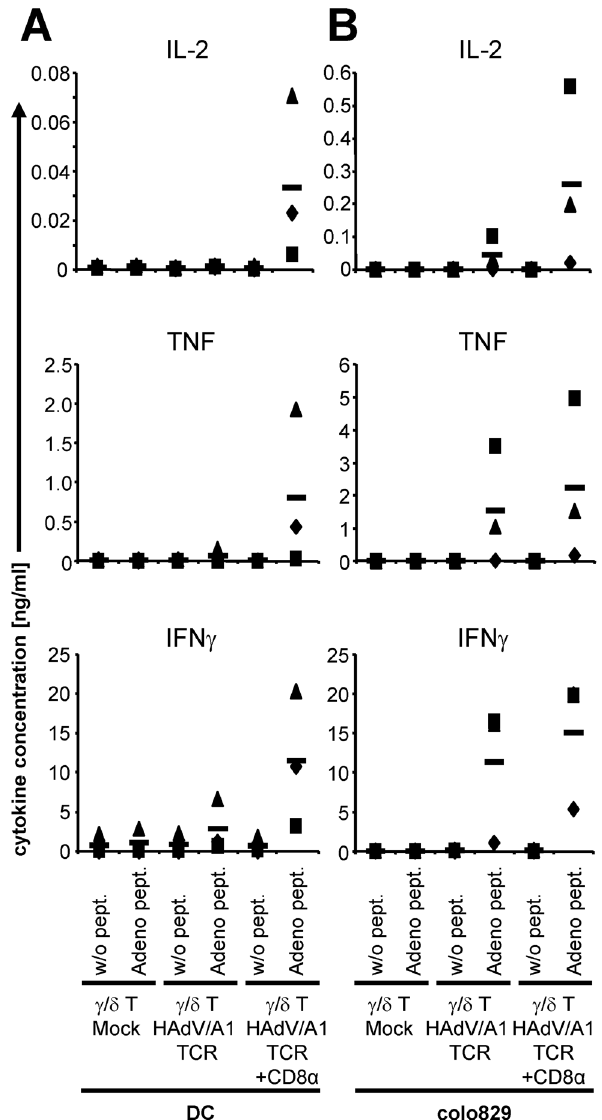
Figure 3. Antigen-specific cytokine production by HAdV/A1- TCR-transfected c / d T cells in response to peptide-loaded target cells. c / d T cells were either mock electroporated, electropo- rated with HAdV/A1-TCR-RNA alone, or electroporated with HAdV/A1- TCR-RNA and CD8 a -RNA. These cells were stimulated with DC ( A ) or colo829 cells ( B ), which were either left unloaded (w/o pept.), or were loaded with the adenovirus peptide (Adeno pept.). Cytokine concen- trations (IL-2, TNF, and IFN c ) in the supernatant after overnight co- incubation are depicted. Data of 3 individual experiments are shown. Bars indicate mean values. Raw data are summarized in Table S3A and B in in File S1.